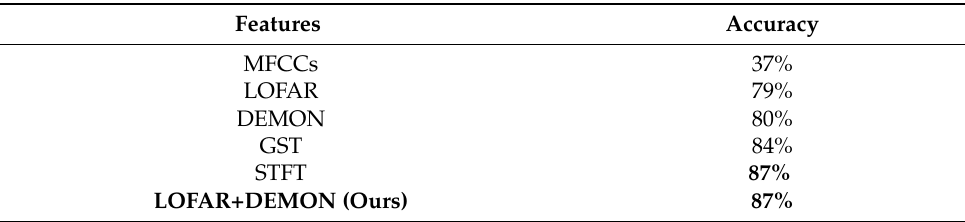
Table 3. Performance of each feature when feeding into the CRNN for object counting on the simulation dataset (COMB excluded).